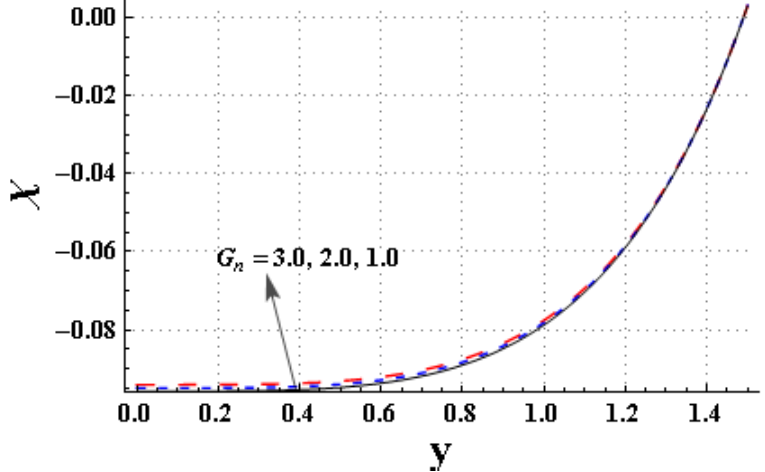
Figure 19. Effect of the bioconvection Rayleigh parameter, G n , on the concentration of motile microorganisms, χ .